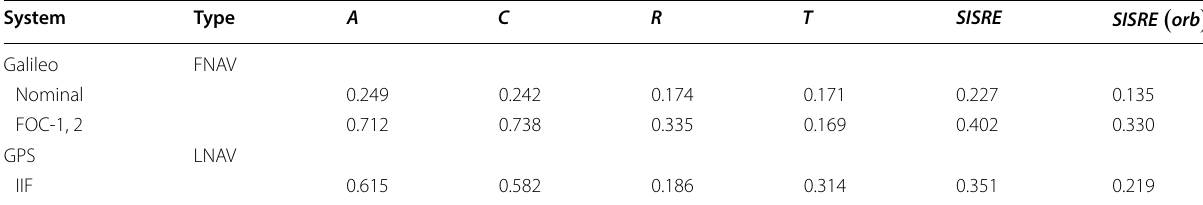
Table 2 Root mean square orbit errors in the along-track ( A ), cross-track ( C ), and radial ( R ) direction and the clock errors ( T ), total and orbit-only SISREs of Galileo and GPS IIF (RAFS) satellites (units: m)